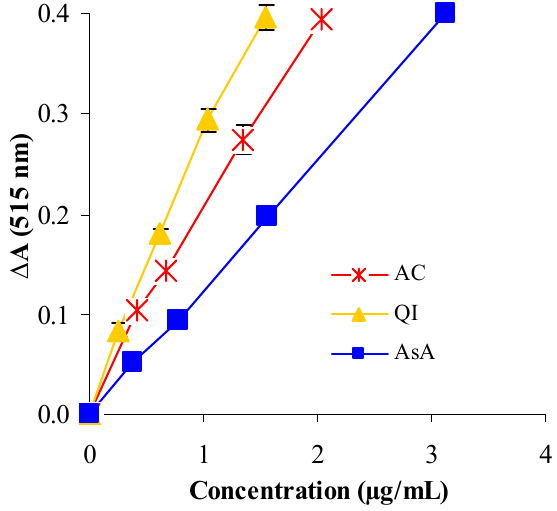
Figure 2. The reduction of DPPH radical measured by the decrease of absorbance at 515 nm, as a function of concentration of test samples and the reference antioxidant (AsA). The Δ A values, obtained after 30 min of reaction, are relative to those of the control excluding added samples or standard.